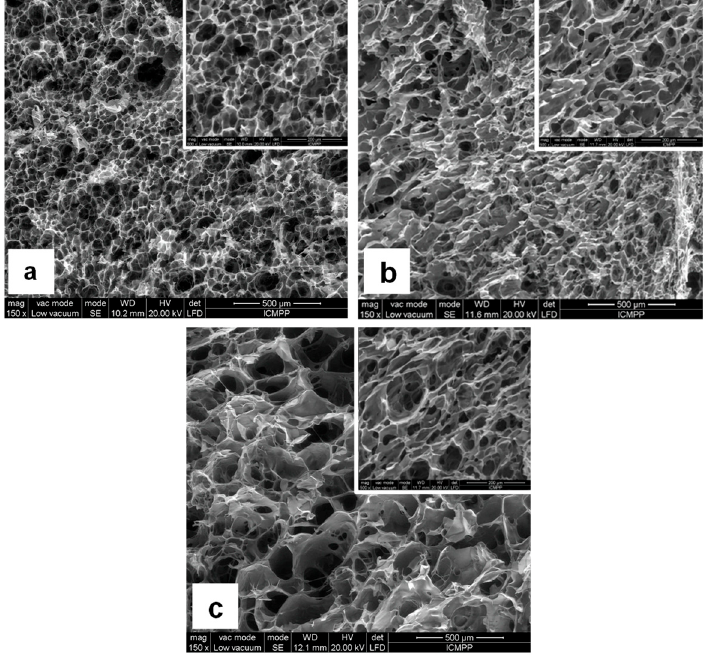
Figure 5. SEM micrographs of freeze-dried hydrogels: ( a ) CMC_PA = 20:1; ( b ) CMC_PA = 10:1; ( c ) CMC_PA = 6:1.